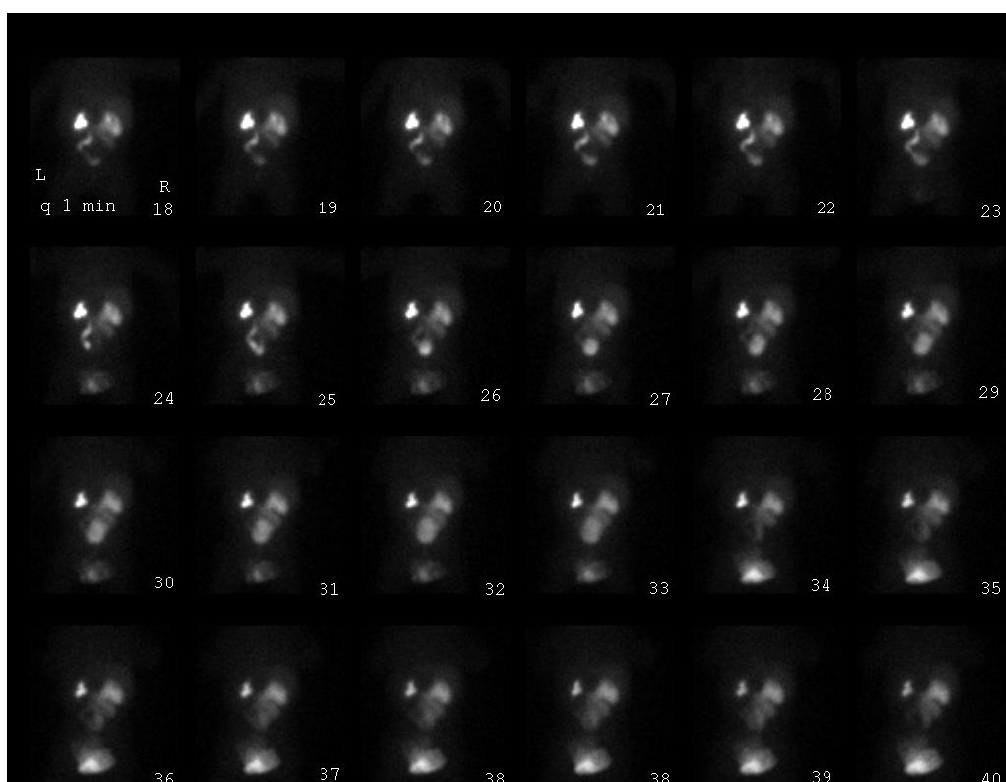
FIGURE 4 . MAG-3 diuretic renogram demonstrating accumulation and stasis of urine in dilated